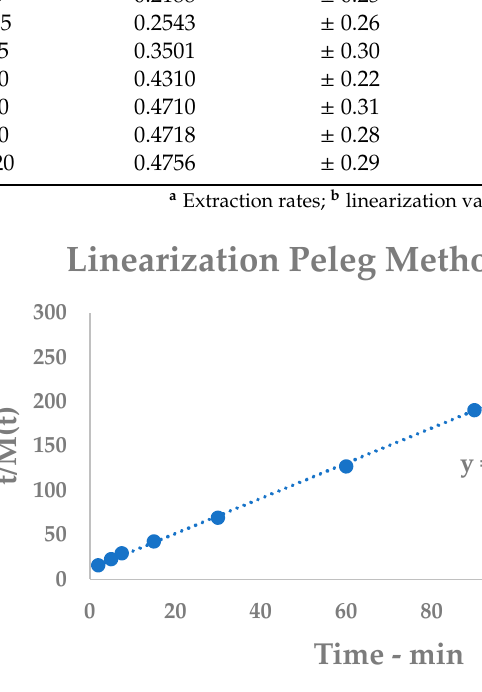
Figure A2. Peleg Model linearization, 2 mm.